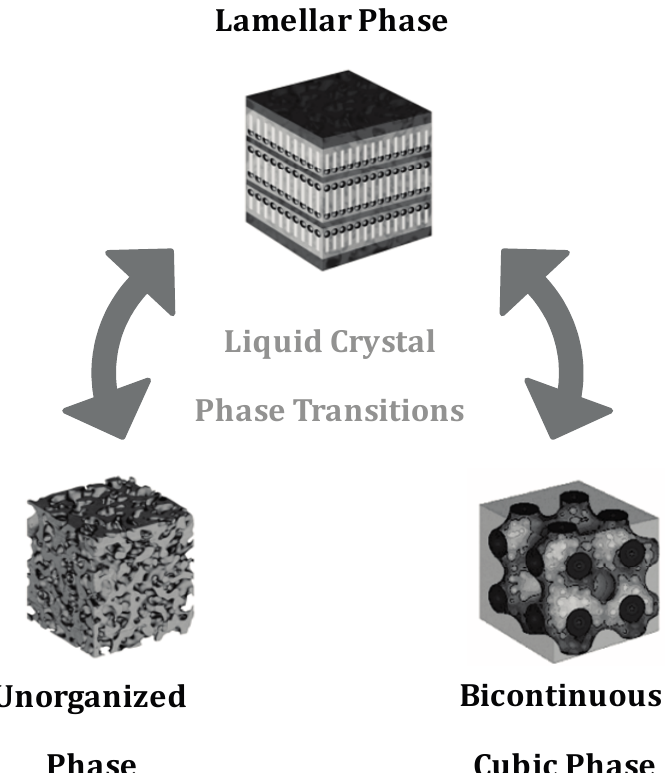
Figure 1. Diagram of lyotropic liquid crystal phase transitions illustrating that a lamellar phase liquid crystal can transition to either an unorganized phase or a bicontinuous cubic phase and back